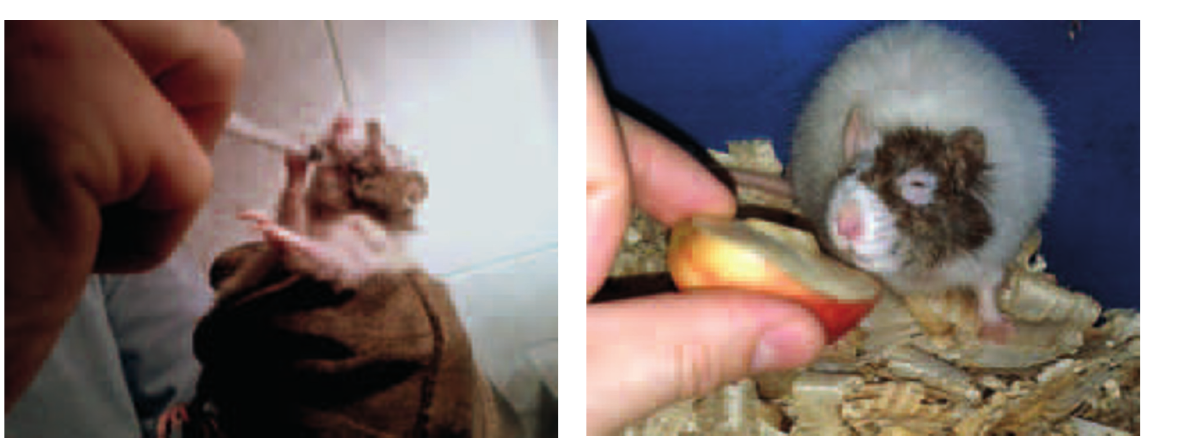
Figure 10. The administration of Cyclosporine A orally